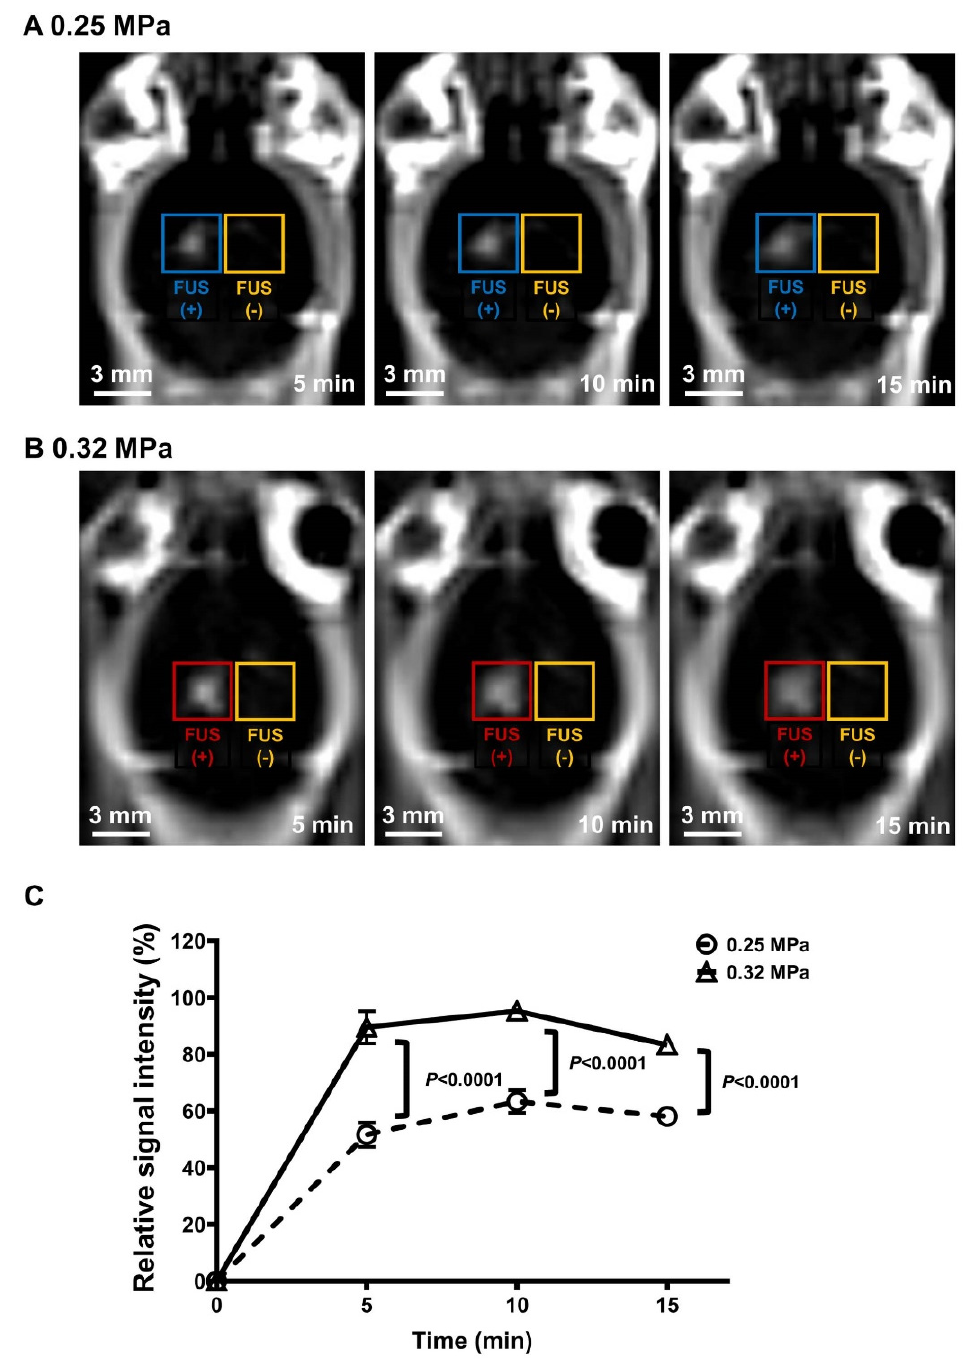
Figure 2. Confirmation of BBBD using two different FUS intensities. ( A , B ) Representative T1w MR images captured from the 0.25 MPa ( A ) and 0.32 MPa ( B ) groups at different time points (5, 10, and 15 min). ( C ) The enhancement of gadolinium signal intensity was calculated by subtracting the signal intensity in the FUS-treated region (0.25 MPa FUS: blue box, circle, and dashed line; 0.32 MPa FUS: red box, triangle, and solid line) from the background intensity in the contralateral region (no-FUS: yellow box). Data are presented as mean ± SEM (N = 4 in each group). Statistical significance was analyzed using a two-tailed unpaired t -test. Scale bars represent 3 mm in ( A , B ).